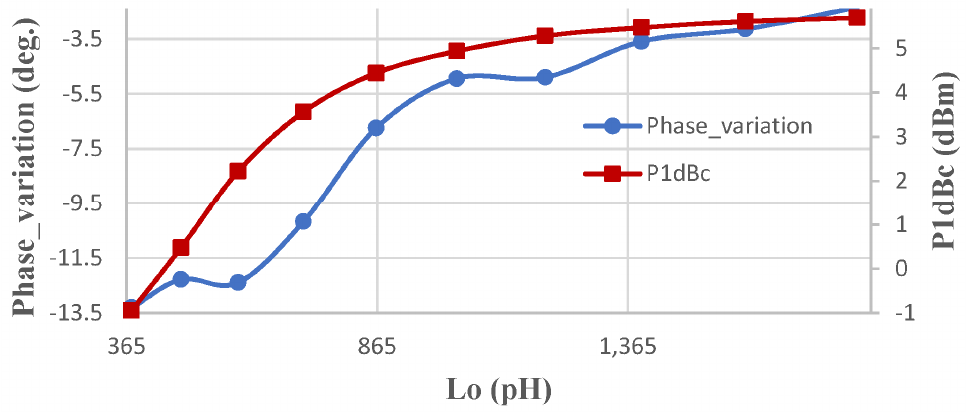
Figure 9. Phase variation and the input P1dB versus the output inductance.